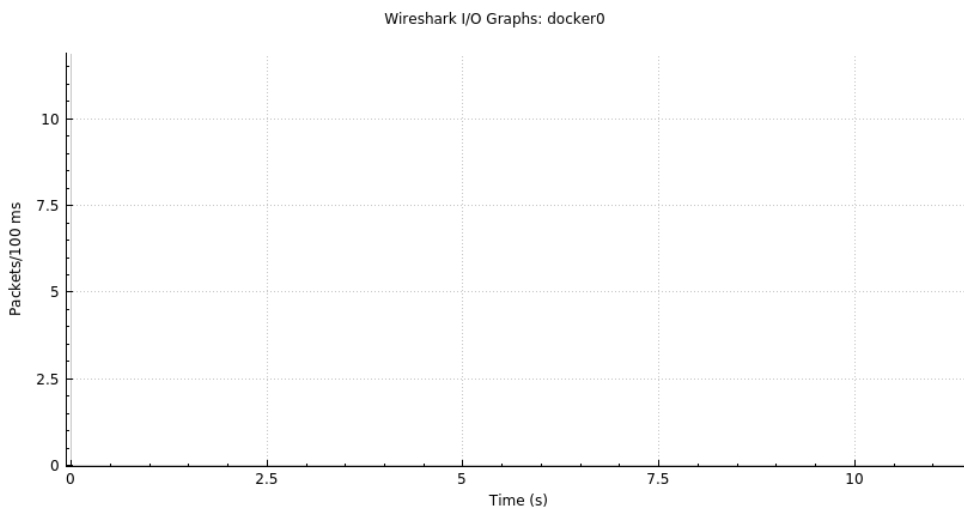
Figure 22. PPS result without the DDoS